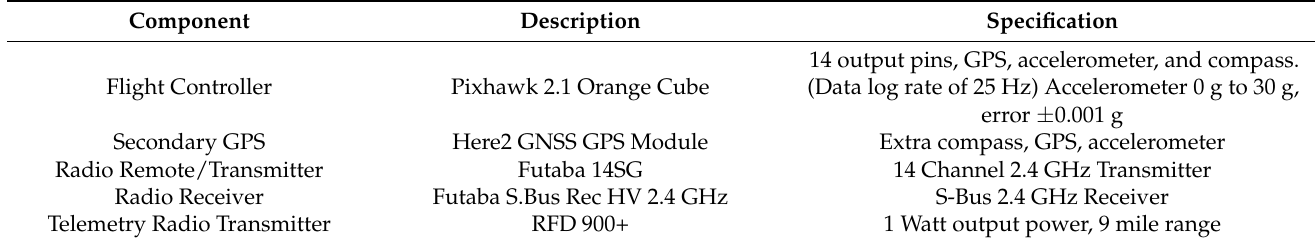
Table 1. Avionics and